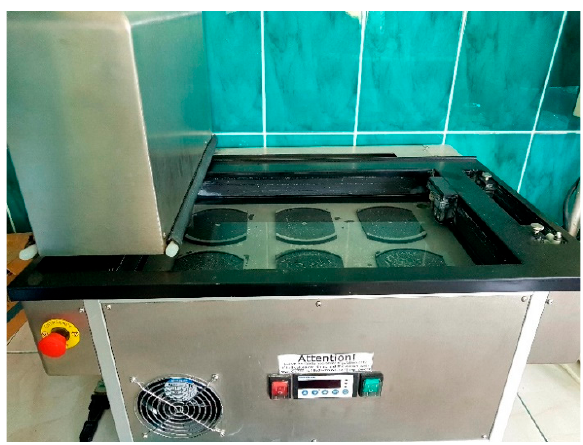
Figure 3. Automated Vicat apparatus.